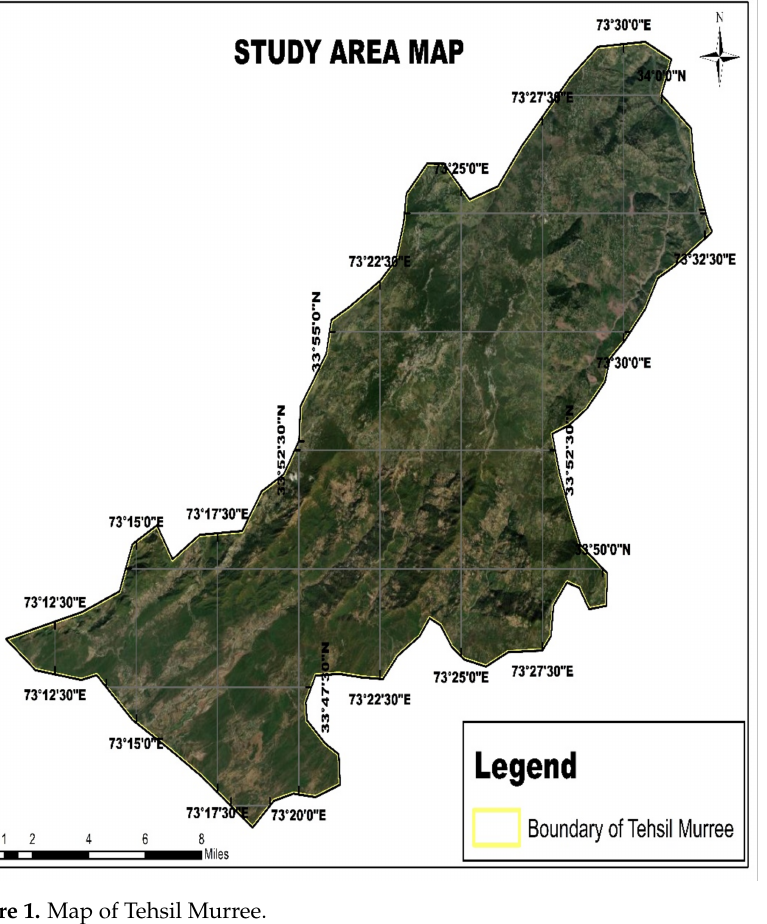
Figure 1. Map of Tehsil